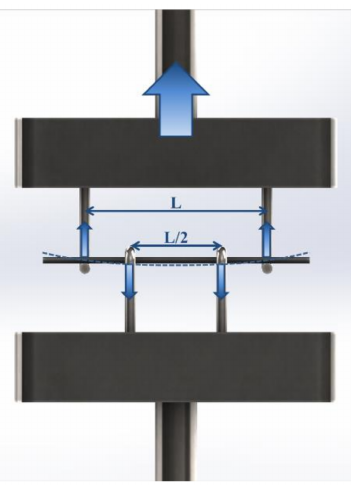
Figure 2. Schematic of the four-point bending test custom equipment and operation on a pyrolyzed filament sample with a diameter of 460 µ m and a length of 20